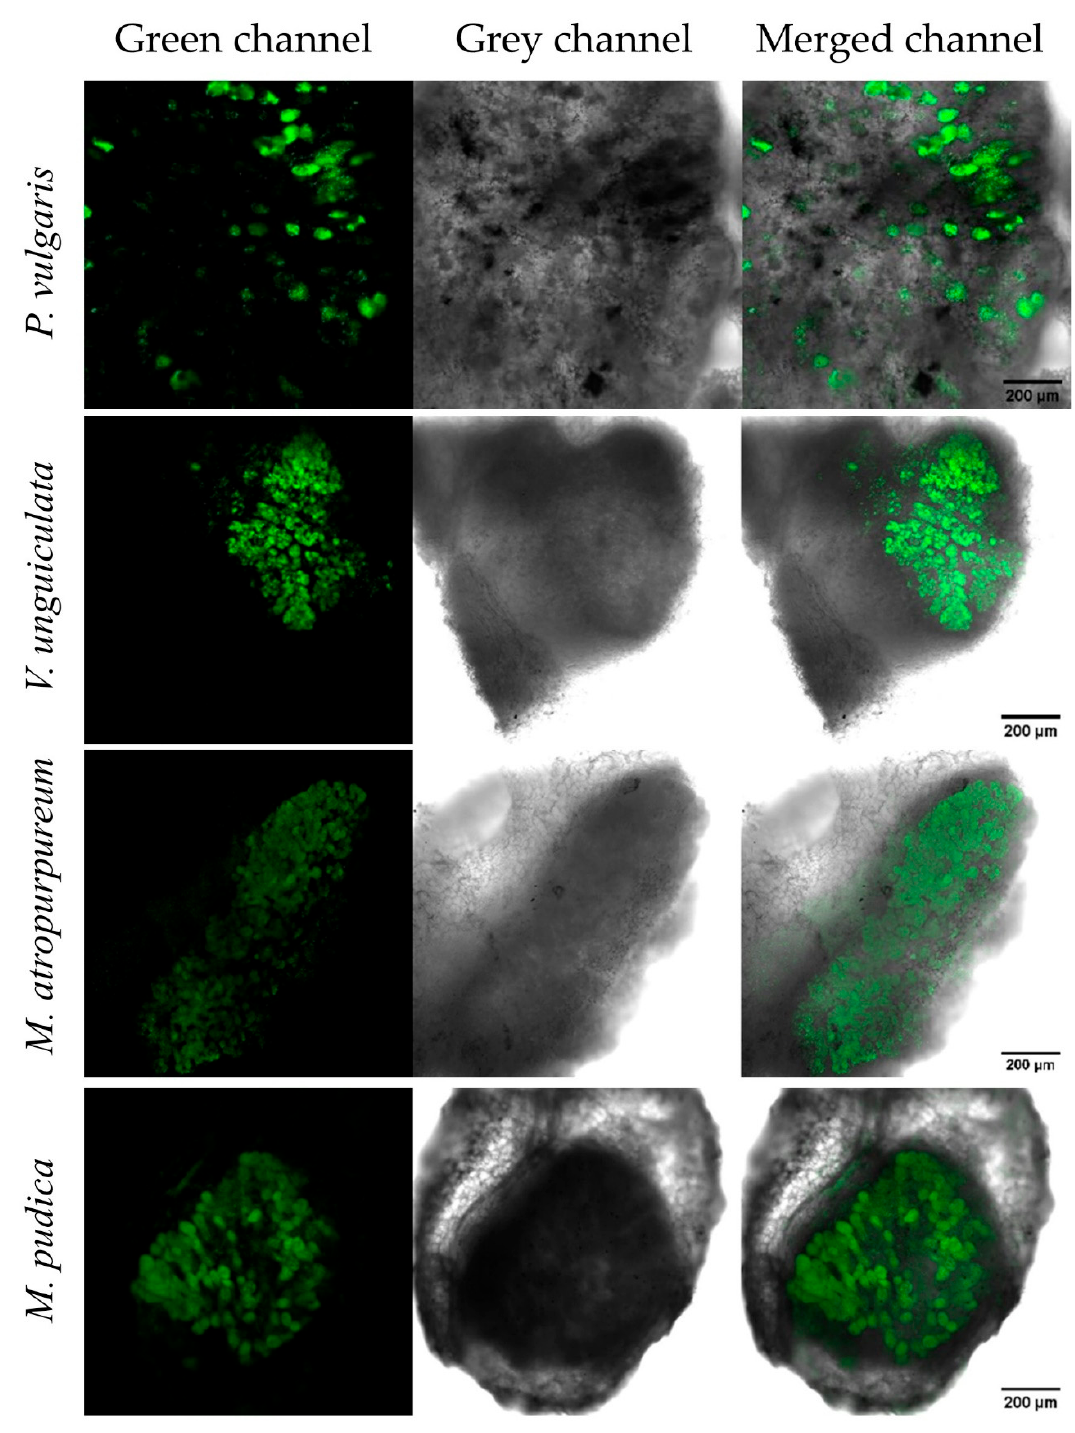
Figure 6. GFP expression of a P. phymatum nifV –GFP reporter strain in nodules of different legumes. P. vulgaris (common bean), V. unguiculata (cowpea), M. atropurpureum (siratro) and M. pudica (mimosa) nodules were analyzed 21 or 28 days post-